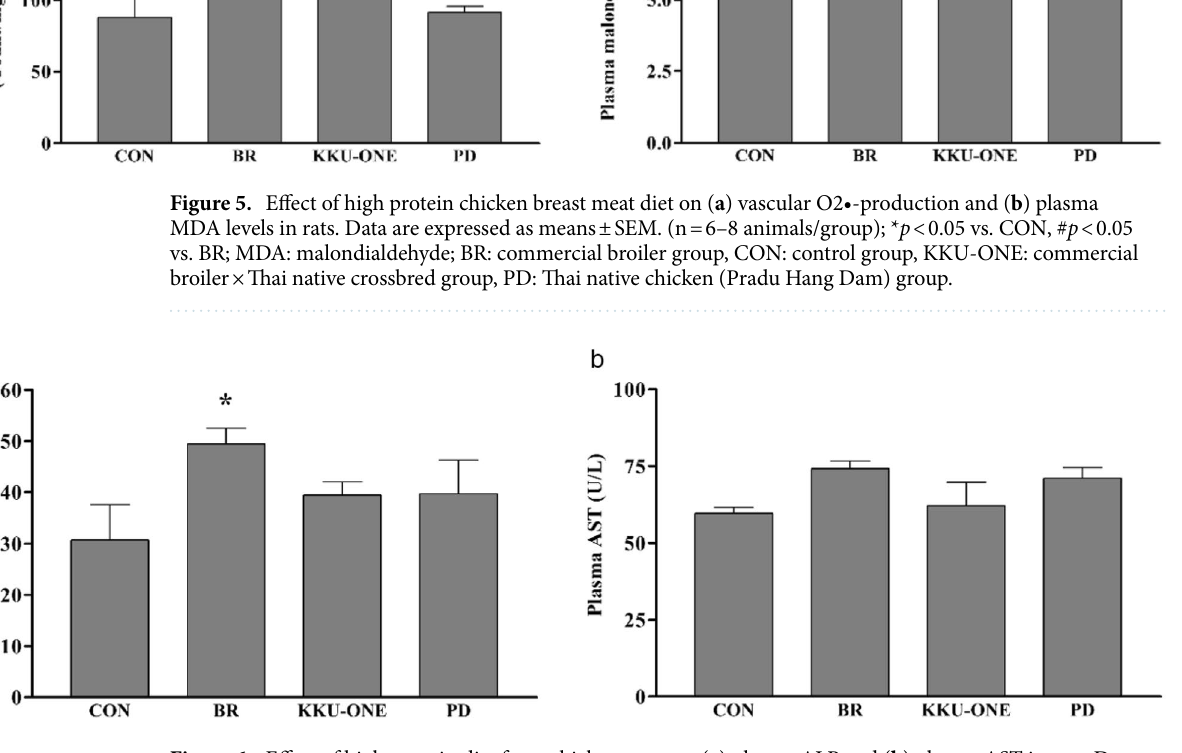
Figure 6. Effect of high-protein diet from chicken meat on ( a ) plasma ALP and ( b ) plasma AST in rats. Data are expressed as means ± SEM. (n = 7 animals/group). * p < 0.05 vs. CON. ALP: alkaline phosphatase,